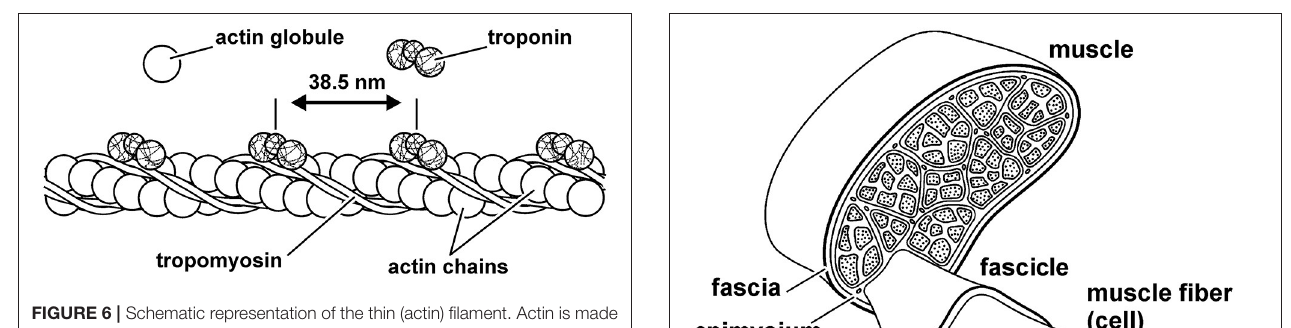
FIGURE 6 | Schematic representation of the thin (actin) filament. Actin is made up of two serially linked chains of actin globules and the repeating structures of the regulatory proteins tropomyosin and troponin. The regulatory protein troponin C binds calcium upon muscle activation, resulting in a configurational change of the troponin–tropomyosin complex that allows for cross-bridge attachment to actin.